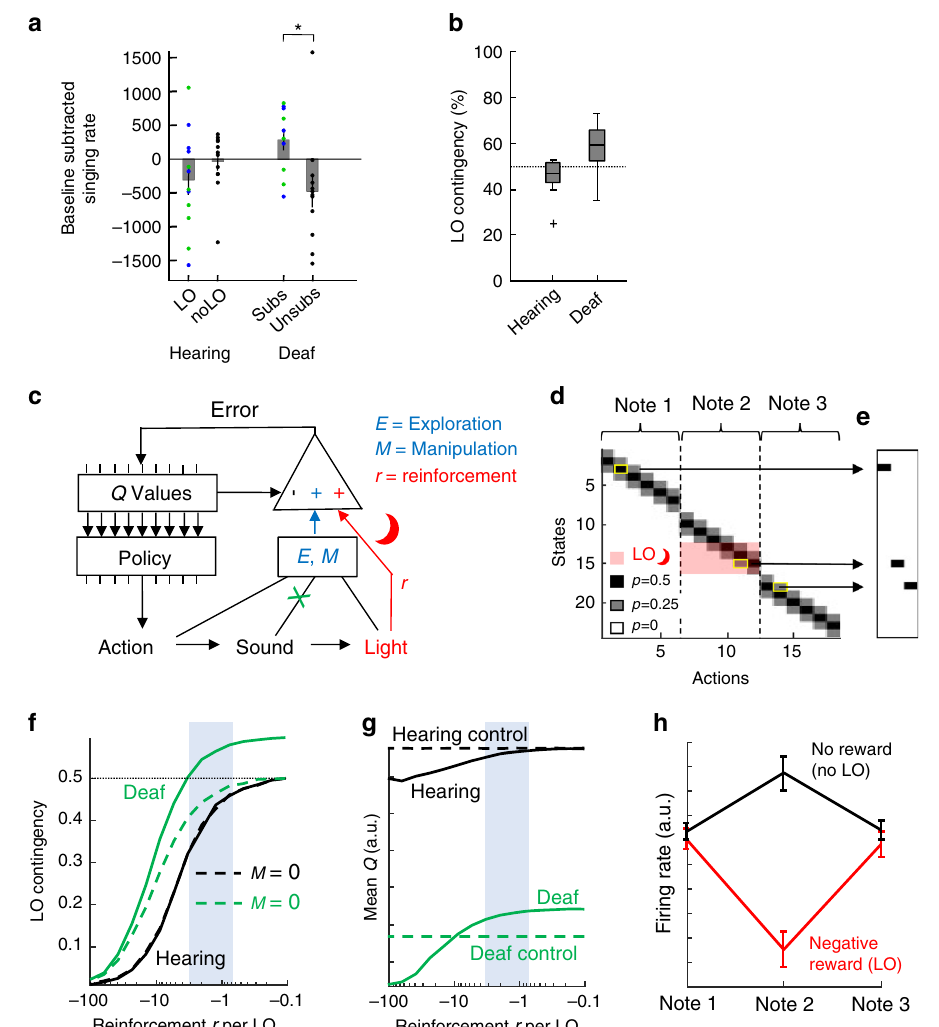
Fig. 4 A manipulation bonus is compatible with valence inversion. a Average change in singing rate during the last three days of light off in deaf ( n = 10) and in hearing birds ( n = 12) and in their time-matched controls ( n = 12 deaf and n = 12 hearing birds). The change is reported relative to the average on the last three days of baseline (* indicates p = 0.02, tstat = − 2.65, df = 20, two-sample two-tailed t -test). The error bars indicate standard errors of the mean and the dots indicate individual birds (blue/green for light off high/low and black for birds that were not subjected to light off events). b Hearing ( n = 12, LO) birds trigger light off on average in <50% of cases whereas deaf ( n = 10, subs) birds do so on average in more than 50%. The center line of the boxplot represents the median, the box bound extends to the 25 th and 75 th percentile and the whiskers extend to the minima and maxima excluding outliers indicated as a black cross (outlier are de fi ned according to MATLAB ’ s default de fi nition as values that are more than 1.5 times the interquartile range away from the top or bottom of the box). c We modeled a simple agent that maximizes total reward formed by the sum of the extrinsic reinforcement r (red), an exploration bonus E , and a manipulation bonus M given by impact. The agent ’ s greedy policy is to choose the action with maximal Q value (expected total reward). Deaf birds receive no auditory input (green cross). d Markov model of an agent that generates one syllable composed of three consecutive notes, each associated with six possible variants (actions). An action triggers one of three possible sensory states with probabilities depicted with gray shading. States 13 – 16 trigger light-off (r e d). e Example syllable generated by the model (the underlying action-state pairs are delimited in yellow in d ). f Hearing birds trigger light-off on <50% of syllables for all choices of negative reinforcement r per LO. Deaf birds reach above the critical level of 50% LO contingency (green), which is not the case when the manipulation bonus is zero (M = 0, dashed line). g Simulated subs birds are more motivated to sing than their controls (unsubs), their mean Q value (green, arbitrary units) is above that of unsubs birds (dashed green). In hearing birds, the situation is reversed, they are less motivated than their controls. The blue dashed area indicates the plausible reinforcement-per-LO region that qualitatively matches our results. h Model neurons ’ fi ring rates (in hearing birds) agree with reward prediction error coding seen in dopaminergic neurons. On aversively reinforced trials during Note 2 (modeling a LO event or an acoustic white-noise stimulus), the fi ring rate decreases (red), whereas on escape trials (no reinforcer, no LO), the fi ring rate increases (black). Error bars depict mean ± standard deviations (across simulated model